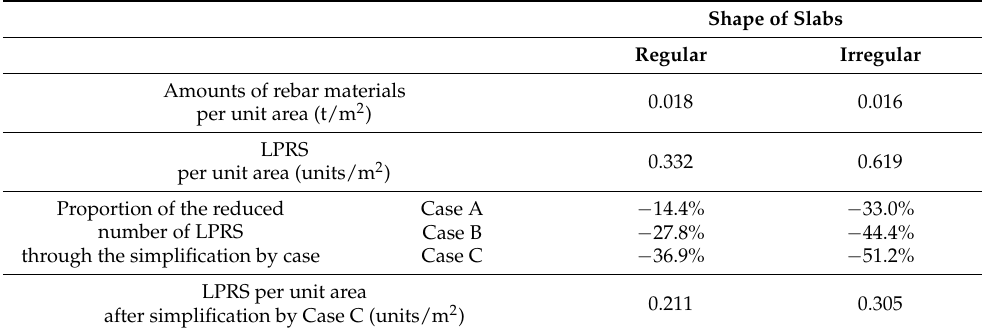
Table 13. Comparison of the calculated values of regular and irregular shapes of slabs.